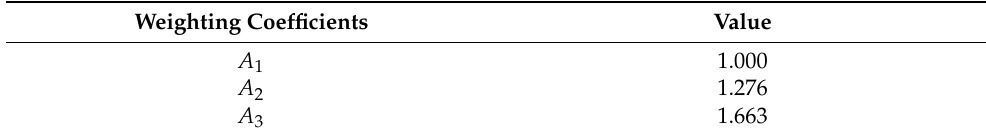
Table 1. Weighting coefficients A n for the first three modes.